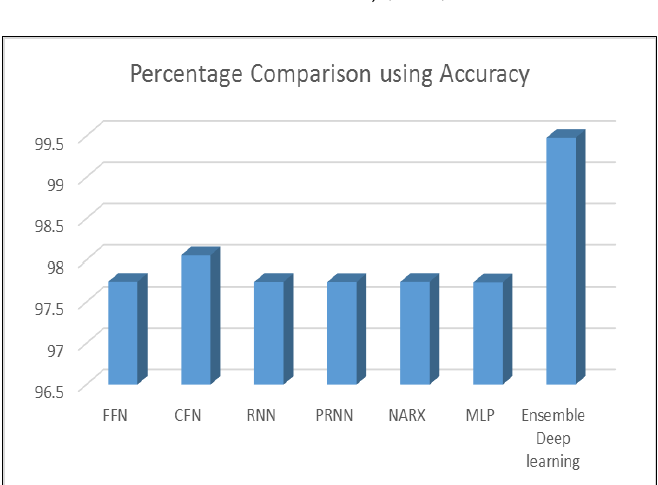
Figure 8: Performance Comparison of models using Percentage Accuracy.